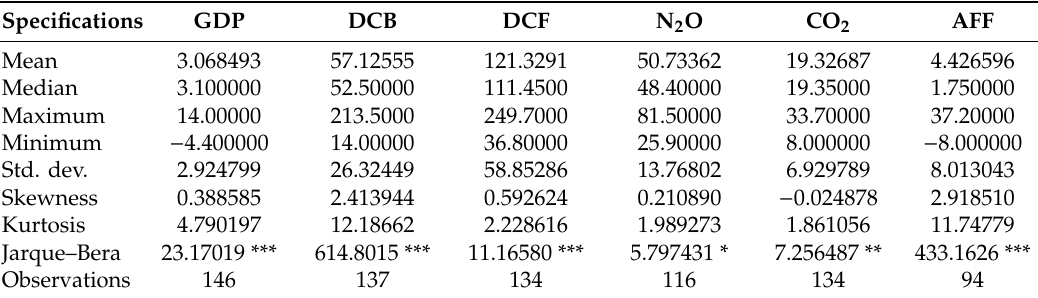
Table 1. Descriptive statistics.